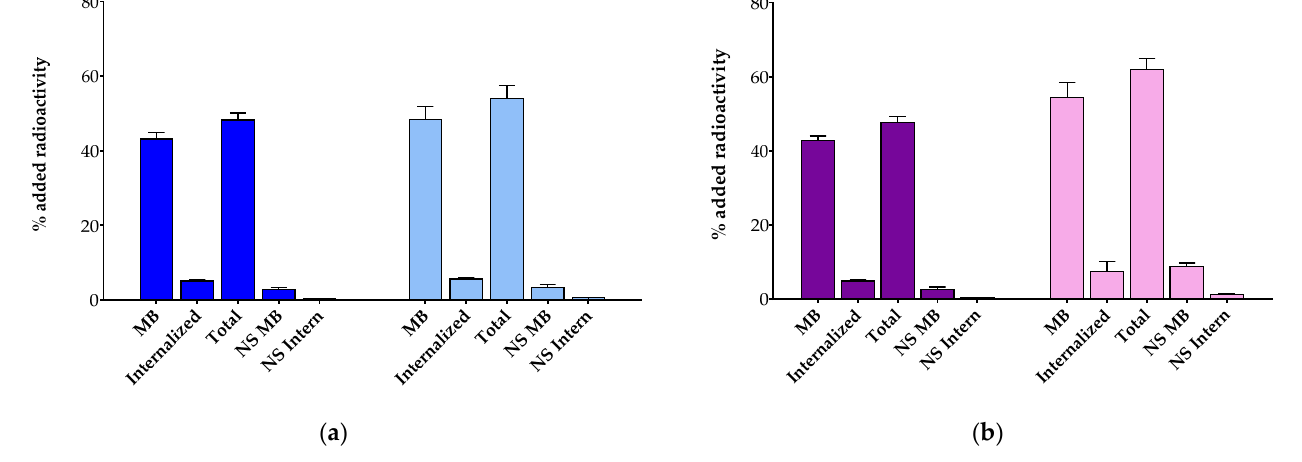
Figure 3. Radioligand uptake internalization during 1 h incubation at 37 °C in HEK293 ‐ SST 2 R cells. ( a ) , [ 111 In]In ‐ AAZTA 5 ‐ LM4 and , [ 111 In]In ‐ DOTA ‐ LM3; ( b ) , [ 177 Lu]Lu ‐ AAZTA 5 ‐ LM4 and , [ 177 Lu]Lu ‐ DOTA ‐ LM3; MB = specific membrane bound, Internalized = specific internalized; Total = specific MB + specific Internalized, NS MB = non ‐ specific MB, NS Intern = non ‐ specific internalized. Results were acquired from 3 independent experiments performed in triplicate.